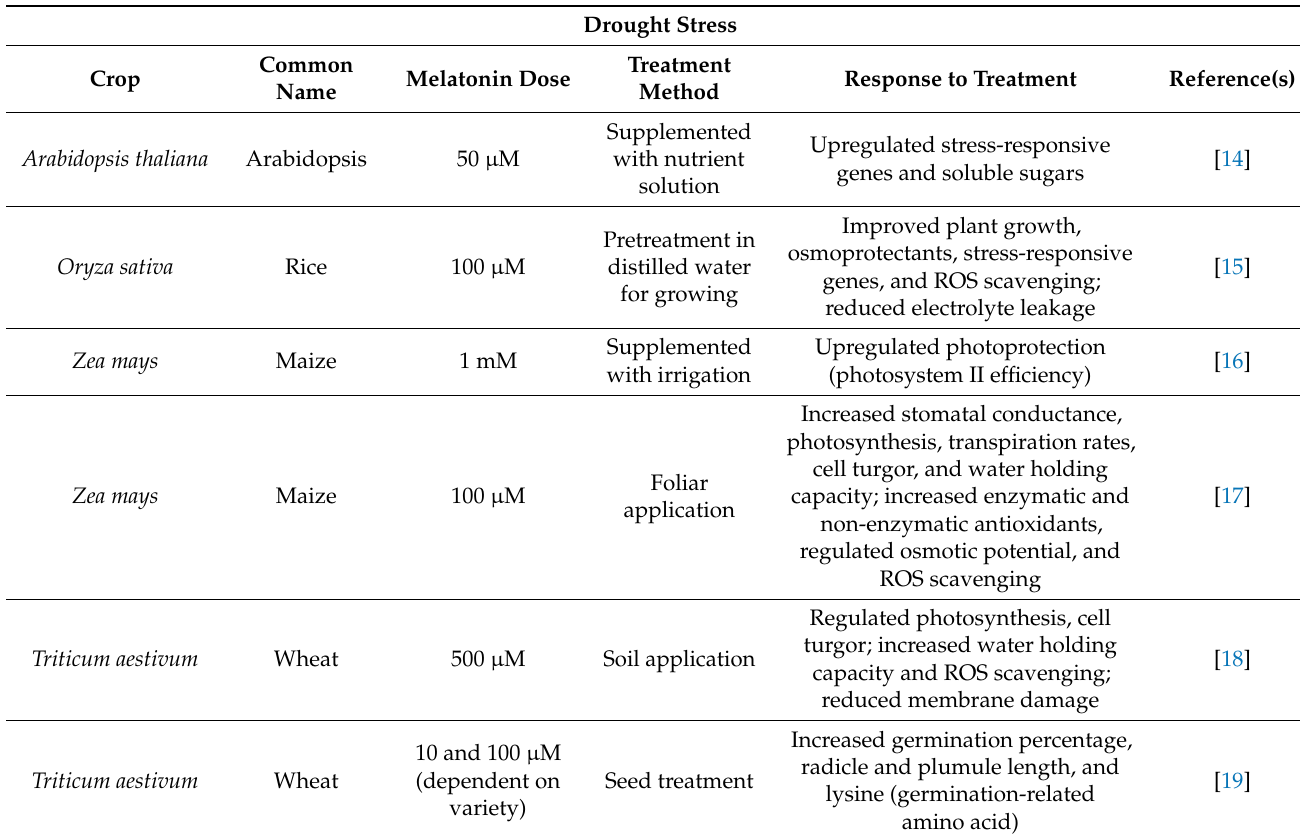
Table 1. Physiological responses of various crops to melatonin treatment against drought